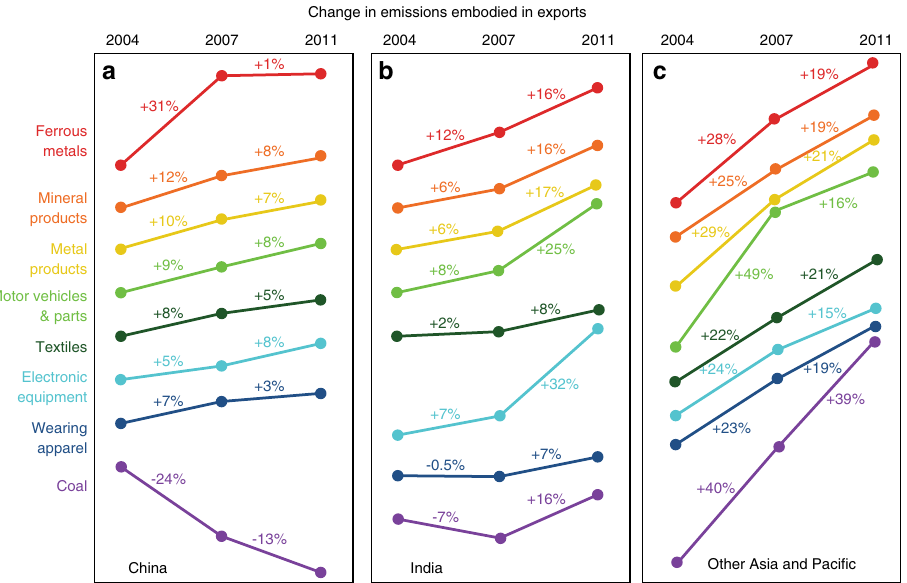
Fig. 4 Annual changes in emissions embodied in selected types of exported products to the rest of World. Lines show relative changes in the emissions embodied in different types of products exported by China ( a ), India ( b ), and other Asia and Paci fi c region ( c ). See details of in Supplementary Data